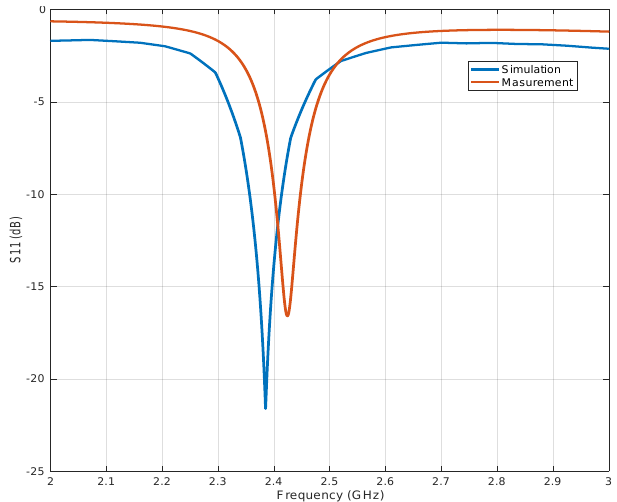
Figure 12. Simulated and measured reflection coefficient ( | S 11 | ) of the inset-fed MPA.